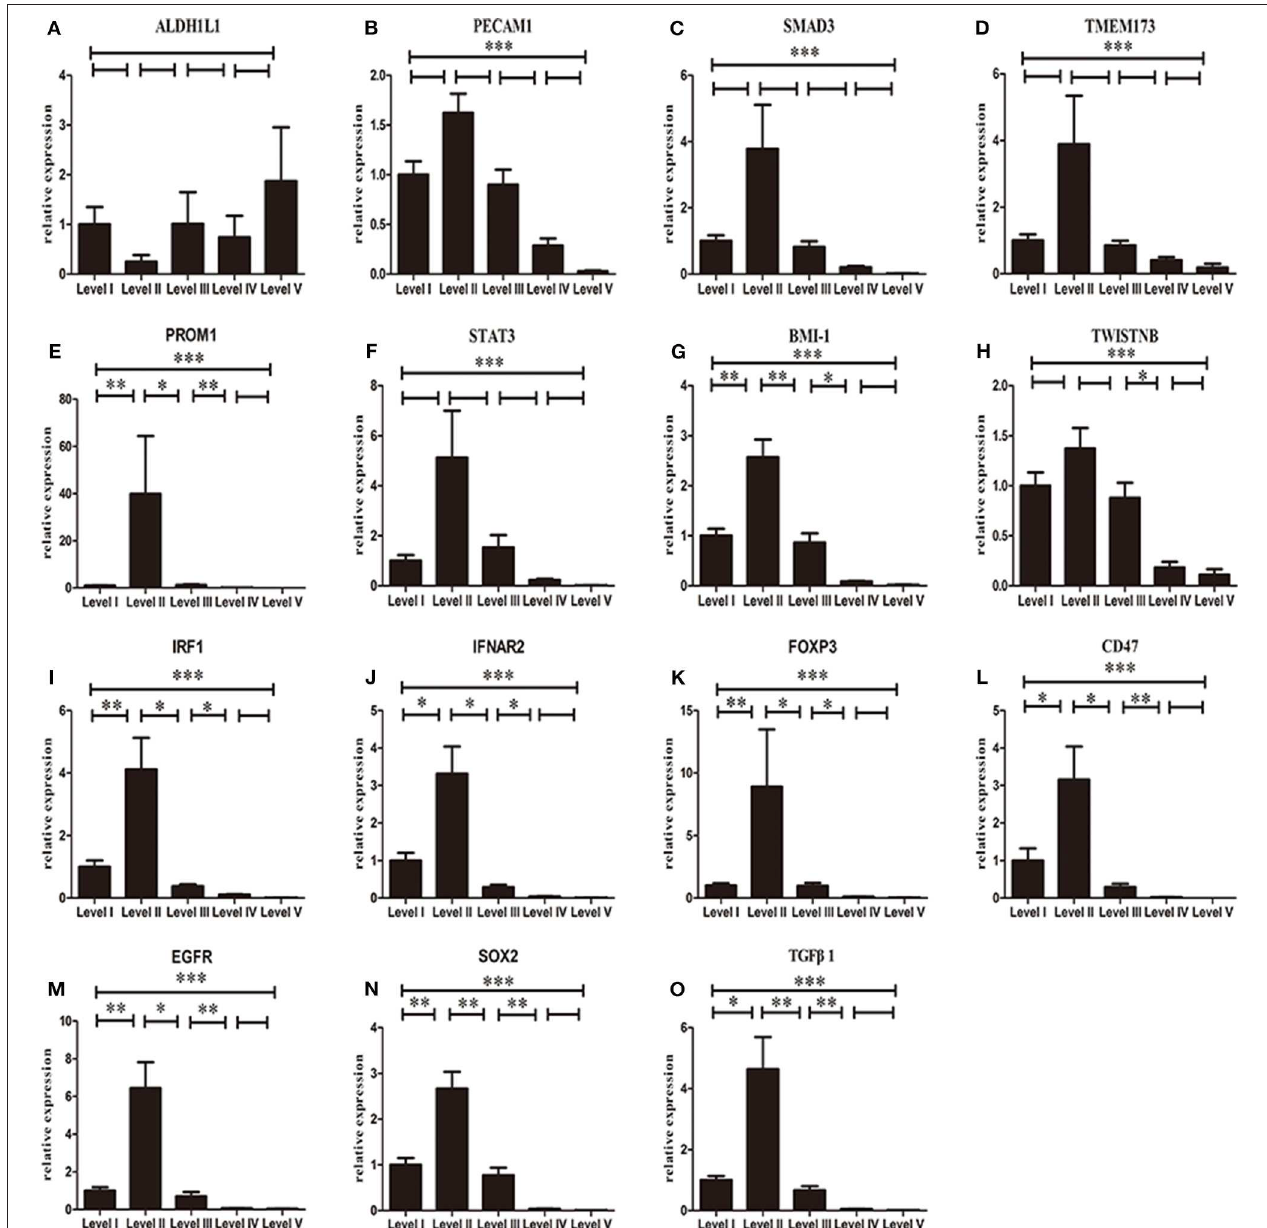
FIGURE 5 | Normalized 2 ( − 11 Ct) mRNA expression of ALDH1L1 (A) , PECAM1 (B) , SMAD3 (C) , TMEM173 (D) , PROM1 (E) , STAT3 (F) , BMI-1 (G) , TWISTNB (H) , IRF1 (I) , IFNAR2 (J) , FOXP3 (K) , CD47 (L) , EGFR (M) , SOX2 (N) , and TGF β 1 (O) in different levels of lymph nodes. Each bar represents the average log2 gene mRNA expression level of the metastatic lymph nodes in each individual level. P -values are calculated by Kruskal–Wallis test (* p < 0.05, ** p < 0.01, *** p <